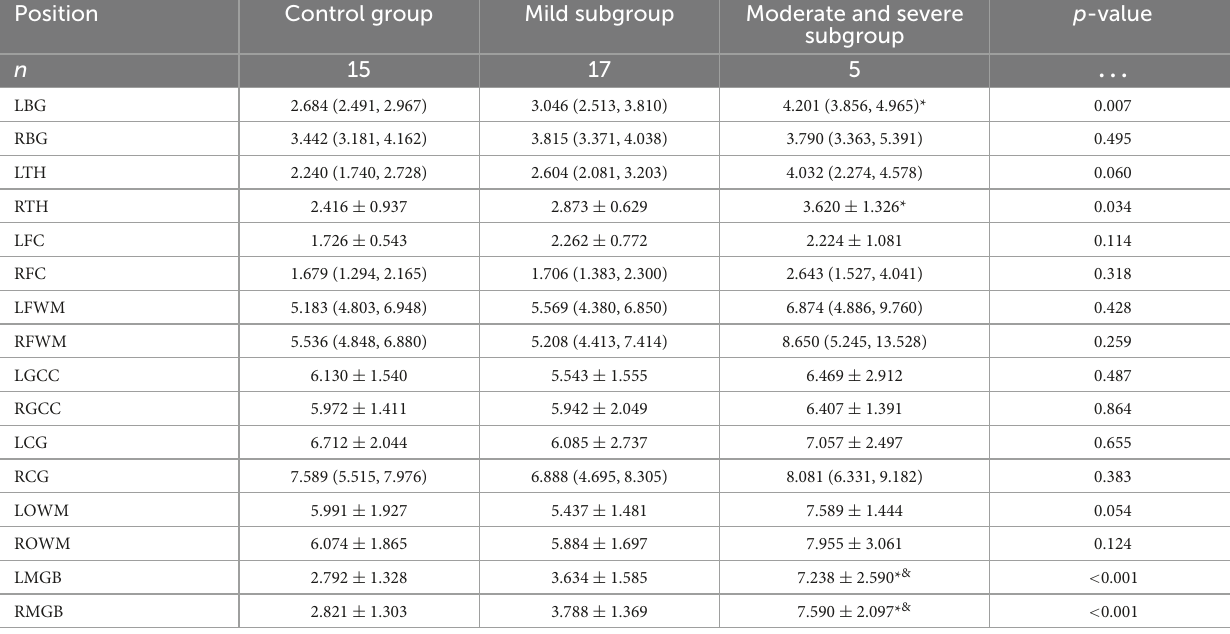
TABLE 5 Glutamate chemical exchange saturation transfer (Glu-CEST)% values for each ROI of different severity groups. Position Control